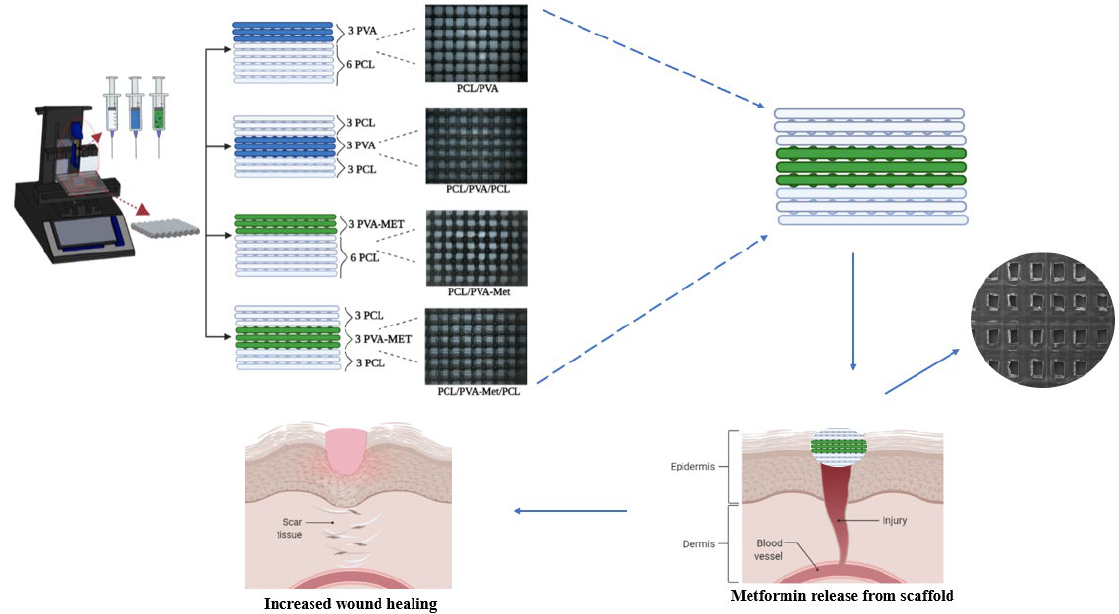
Figure 1. Production and characterization of the scaffolds using 3D printing and demonstration of their role in the wound healing process.